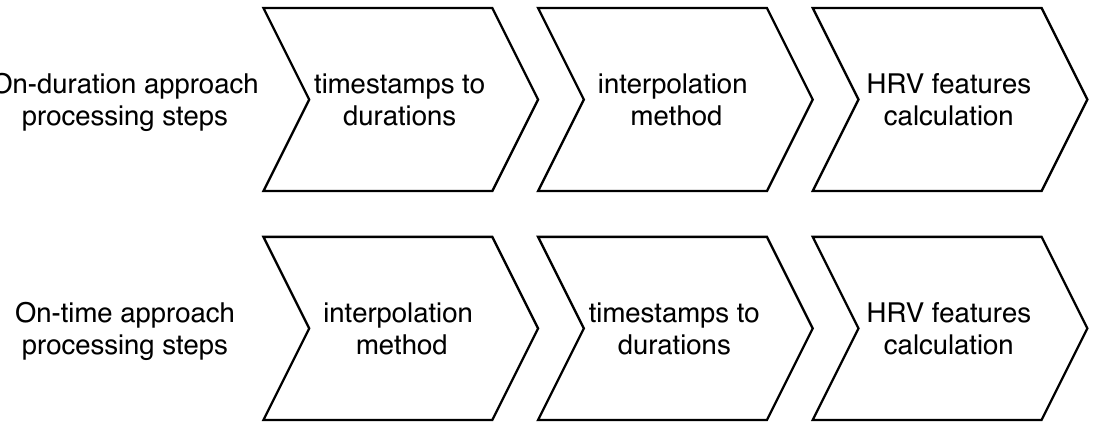
Figure 3. Processing steps in the on-time and in the on-duration approaches.